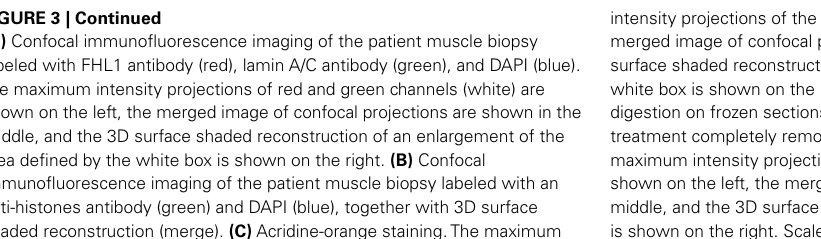
FIGURE 3 | Continued (A) Confocal immunofluorescence imaging of the patient muscle biopsy labeled with FHL1 antibody (red), lamin A/C antibody (green), and DAPI (blue). The maximum intensity projections of red and green channels (white) are shown on the left, the merged image of confocal projections are shown in the middle, and the 3D surface shaded reconstruction of an enlargement of the area defined by the white box is shown on the right. (B) Confocal immunofluorescence imaging of the patient muscle biopsy labeled with an anti-histones antibody (green) and DAPI (blue), together with 3D surface shaded reconstruction (merge). (C) Acridine-orange staining.The maximum